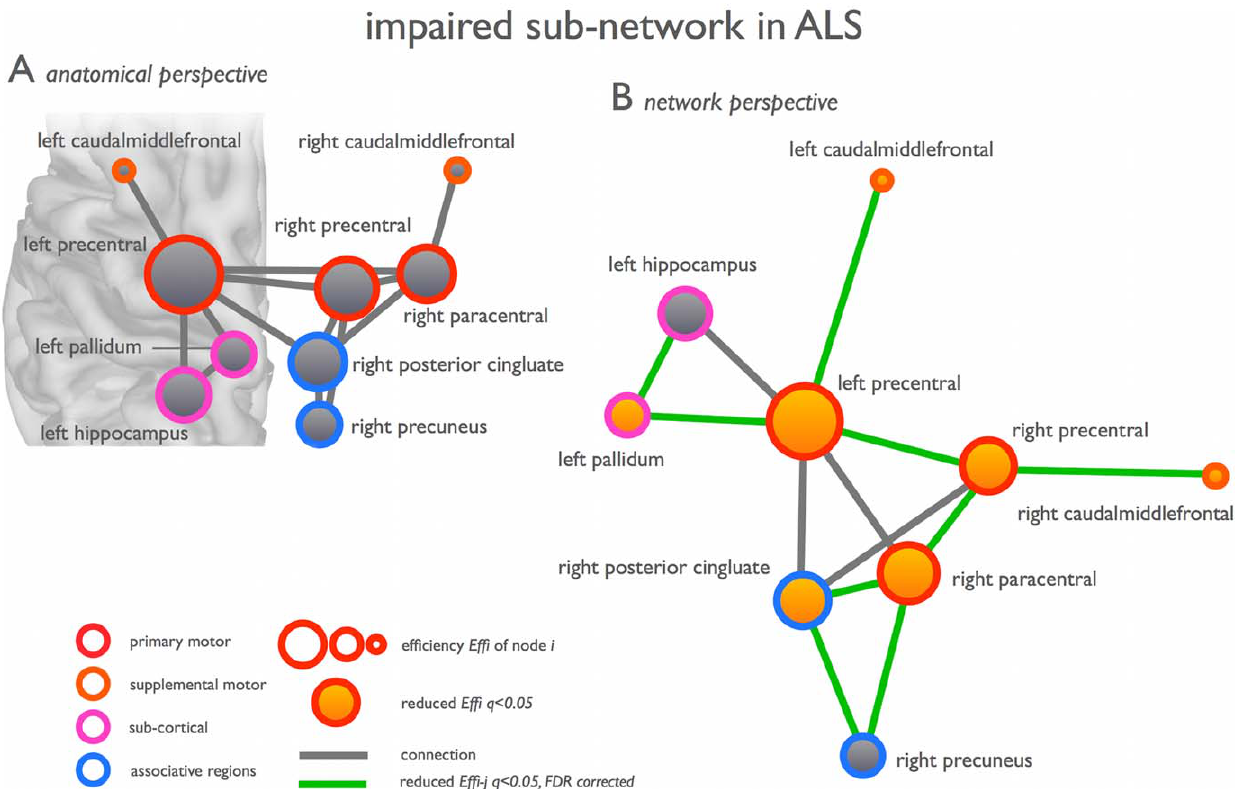
Figure 4. Network of impaired structural connectivity in ALS. (a) The nodes and interconnections of the NBS network (NBSa network, Figure 2a) as viewed from an anatomical perspective. (b) The NBS network from a network perspective (optimizing free Kamada-Kawai energy, constructed with pajek http://vlado.fmf.uni-lj.si/pub/networks/pajek/). Nodes and connections showing significantly reduced efficiency in patients are